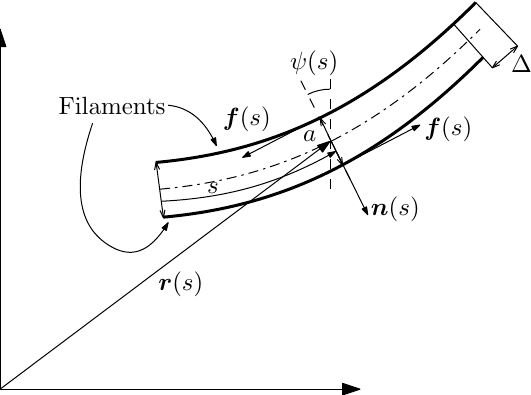
Figure 2. Geometric model of an axonemal